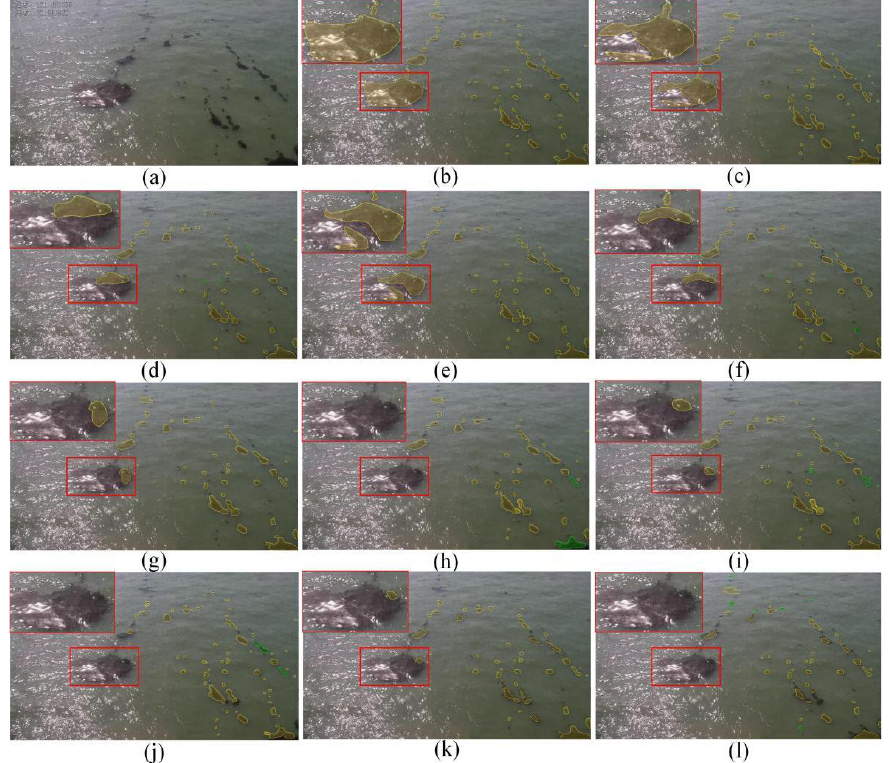
Remote Sens. 2022 , 14 , x FOR PEER REVIEW Figure 18. The visual comparison of results of different models in scene 5. Figure 18. The visual comparison of results of different models in scene 5.